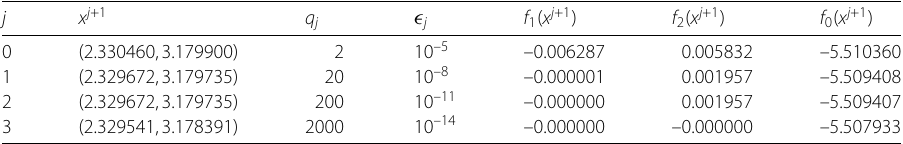
Table 9 Numerical results for Example 4.3 with x 0 =